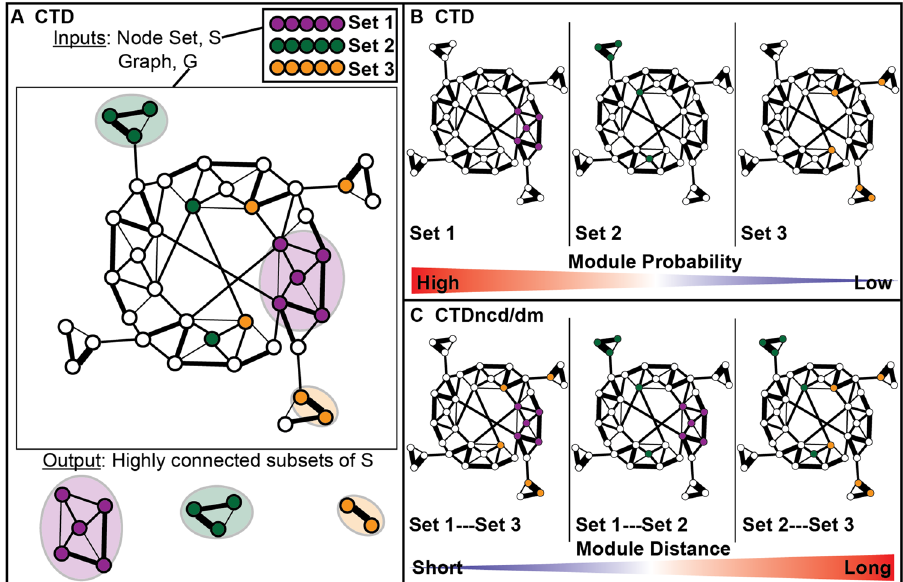
Figure 2. CTDncd and CTDdm extend CTD to quantify distances between two sets of nodes in a network. ( A ) CTD outputs highly connected subsets of a node set (given as an input) in a graph (also given as an input). ( B ) CTD assigns higher significance to highly connected node sets compared to sparsely connected node sets. ( C ) Node sets found in identical or neighboring regions in a graph are assigned shorter distances compared to node sets found in distal regions of a graph. CTDncd calculates distances between two individuals, where node sets being compared are based on observed metabolite perturbations in two individuals’ metabolomics profiles. CTDdm calculates distances between an individual and a disease state, where node sets being compared are the main disease module in a graph (see Algorithm 1 in Supplemental Text 1) and the observed metabolite perturbations in a single individual’s metabolomic